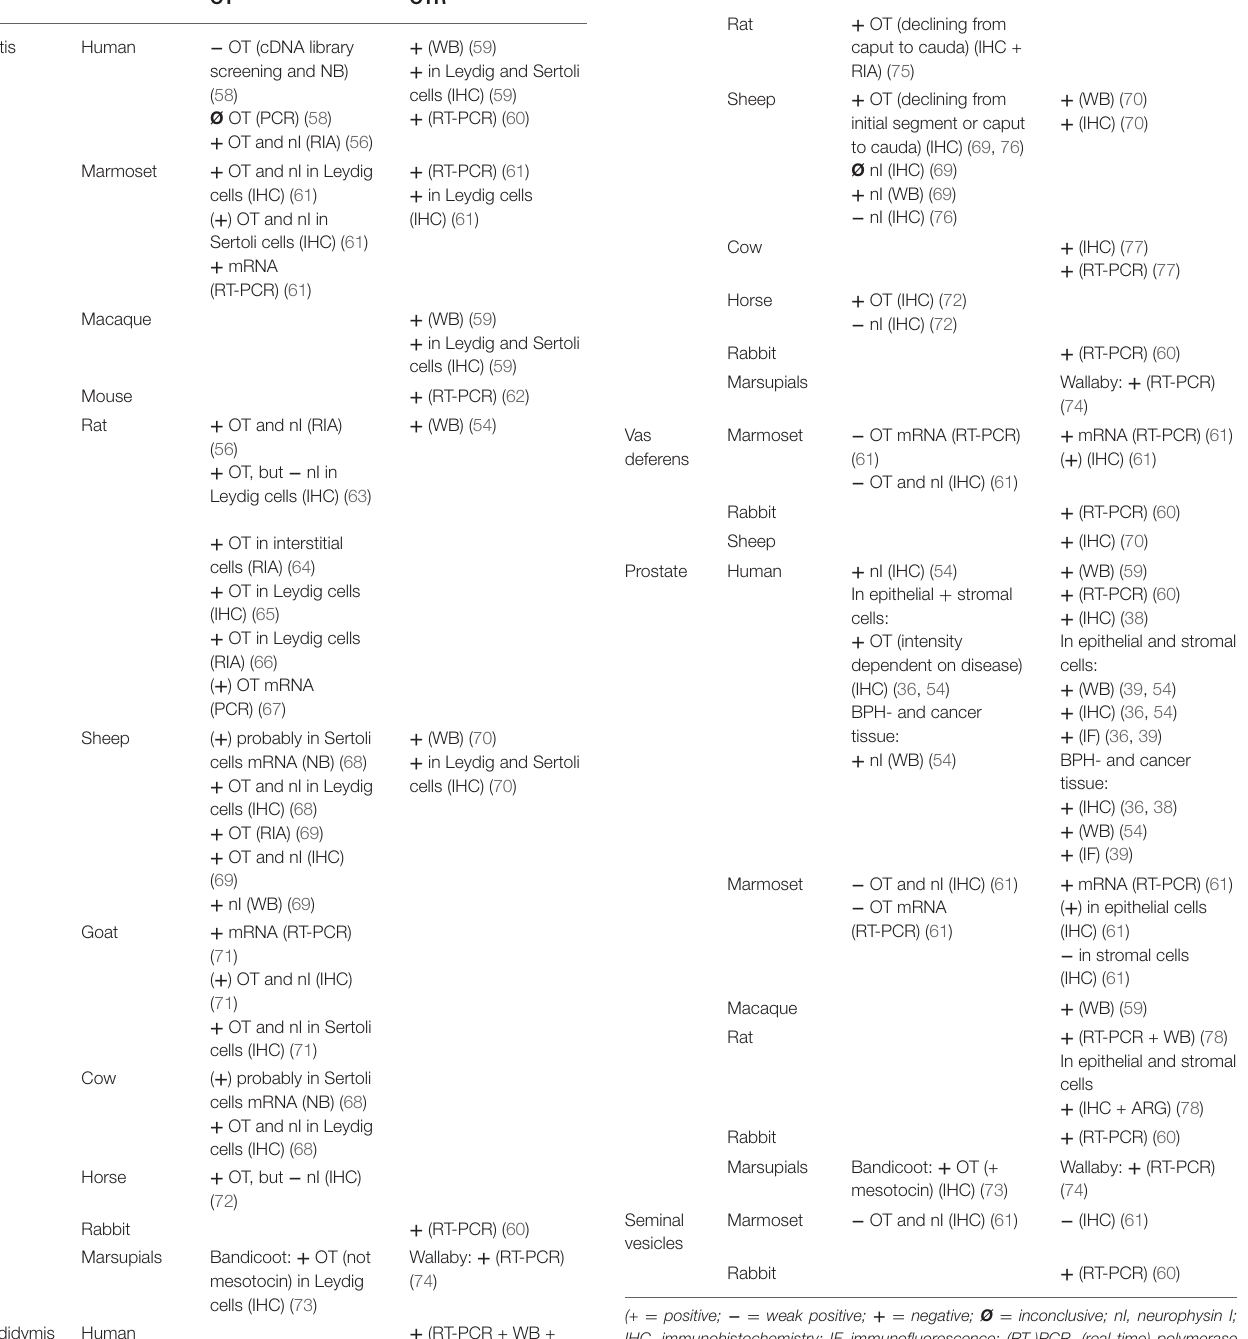
TABLE 1 | Original: Expression and localization of OT and OTR in different species throughout the male reproductive tract. OT OTR